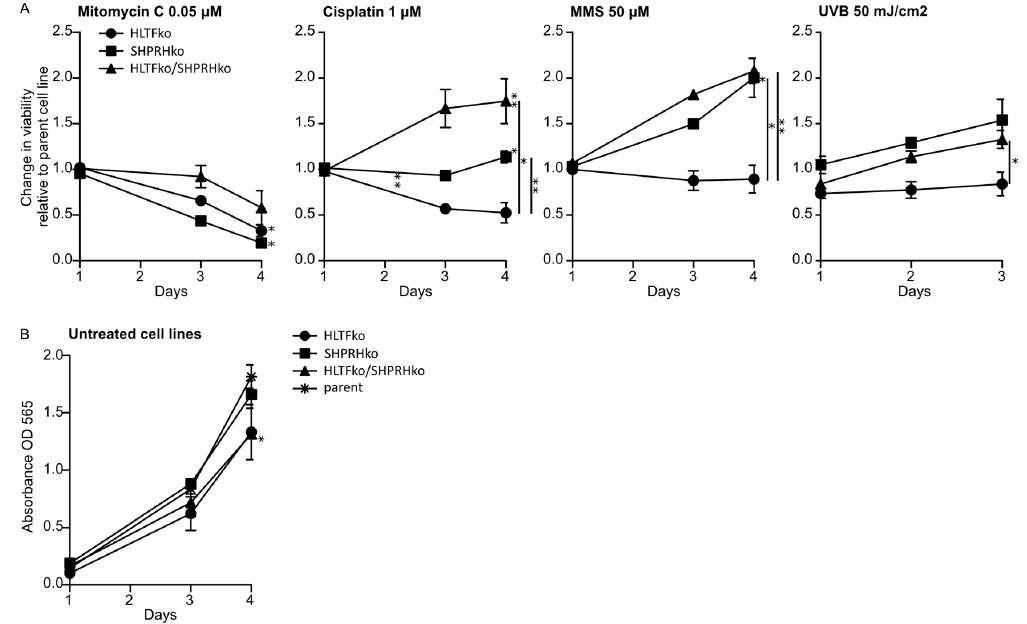
Figure 1. Knockouts of helicase-like transcription factor (HLTF) and SNF2, histone-linker, PHD and RING finger domain-containing helicase (SHPRH) reduces sensitivity towards several DNA damaging agents. ( A ) Viability over 3–4 days was measured in all cell lines after exposure to mitomycin-C (MMC) (0.05 µ M), cisplatin (1 µ M), methyl methanesulfonate (MMS) (50 µ M) or UV (50 mJ / cm 2 ). Change in viability in treated versus untreated ko cell normalized to similarly treated parental cells are shown, i.e., value of 1 represents the same response as in parental cells (3 independent experiments ± SD are shown). Representative parental cell response to the treatments are shown in Figure A2. ( B ) Normal growth of untreated cell lines. Two-sided student’s t -test, * p < 0.05, ** p < 0.01.